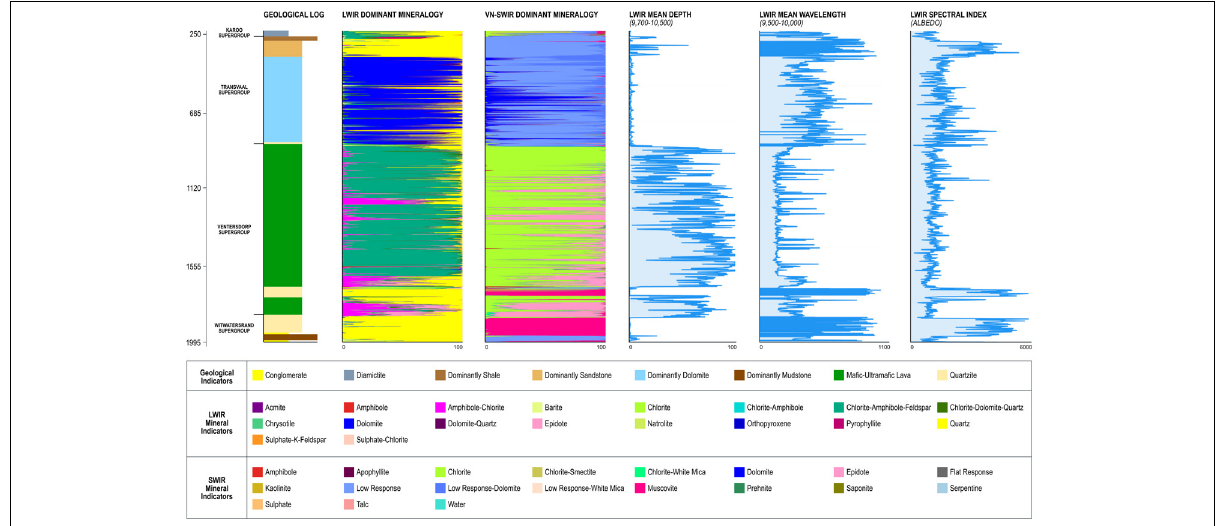
Figure 5: Overview of hyperspectral data acquired on borehole BH 2068. Figure includes simplified geological log; dominant mineral map from the visible- near infrared to long-wave infrared; long-wave infrared mean depth ranges, wavelength, and spectral index.